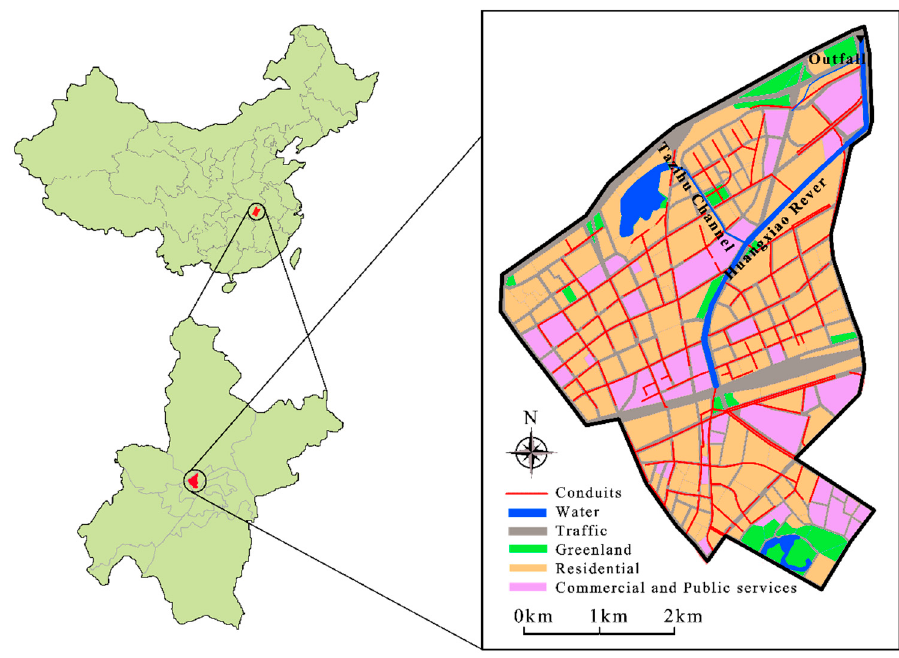
Figure 2. Study area and drainage channels.